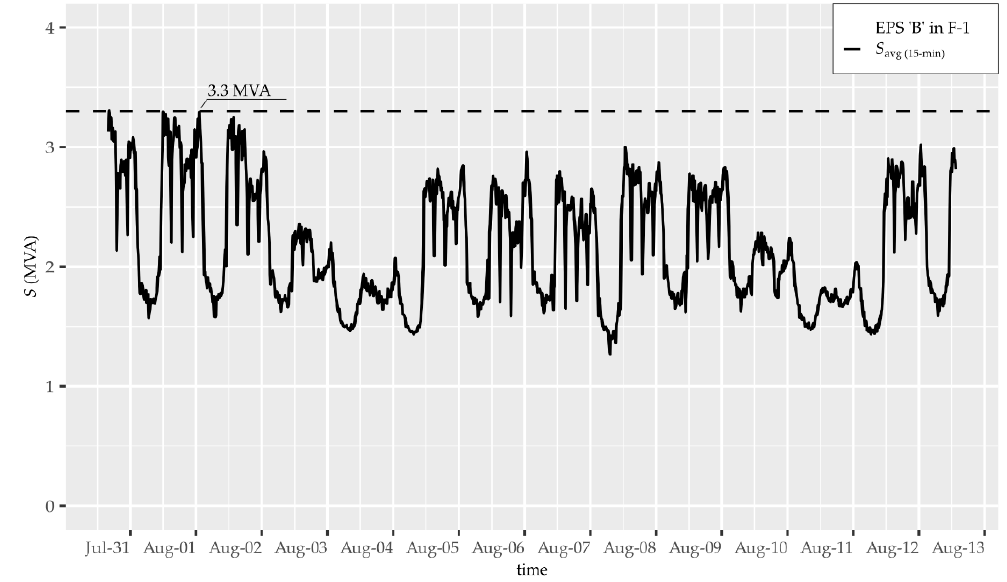
Figure 12. The S EPS “B” power profile of the EPS “B” substation in the failure operating condition F-1. Figure 13 shows the 2-week power flow S of the industrial plant “IP” in the operation condition N, F-1 and indicates the power limit to which the recipient must limit themself in the failure operation condition F-2 and island operation F-2* of a considered network.